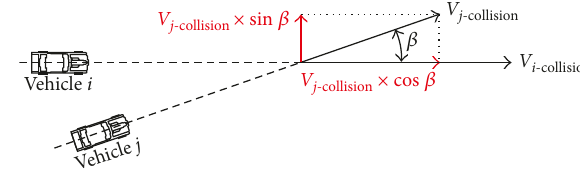
Figure 2: Decomposition of the speed vectors of vehicle j parallel with and perpendicular to the movement direction of vehicle i .